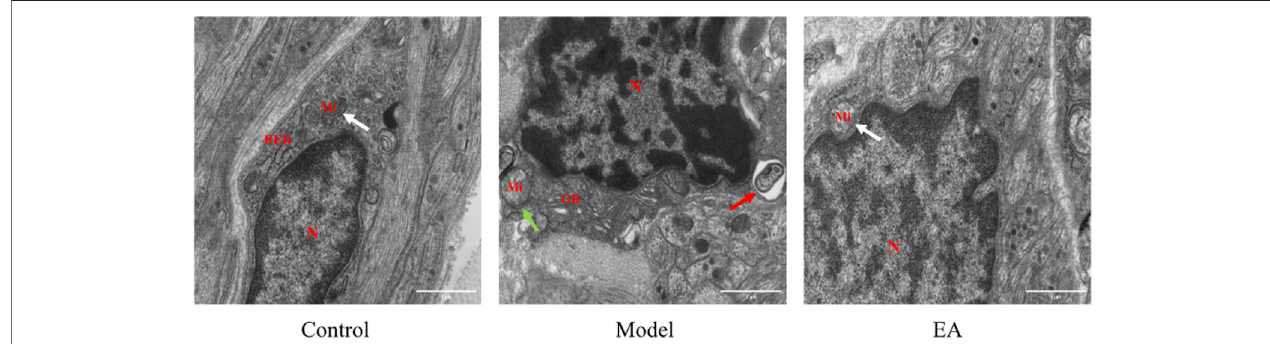
FIGURE5| MorphologyofEGCinthesubmucosallayerunderTEM(×30,000).N:nucleus,Mi:mitochondrion,RER:roughendoplasmicreticulum,GB:Golgibody. In the submucosal layer, autophagy ( ) and mitochondrial swelling ( ) were observed in the model group, and normal mitochondrion ( ) wasobserved inthe control and EA groups. Scale bar = 1 μ m, n = 3.